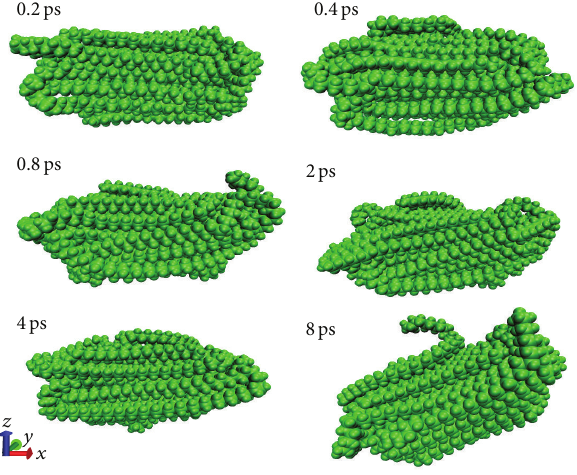
Figure 4: The final structures of the VEMD simulations with different vibration periods.